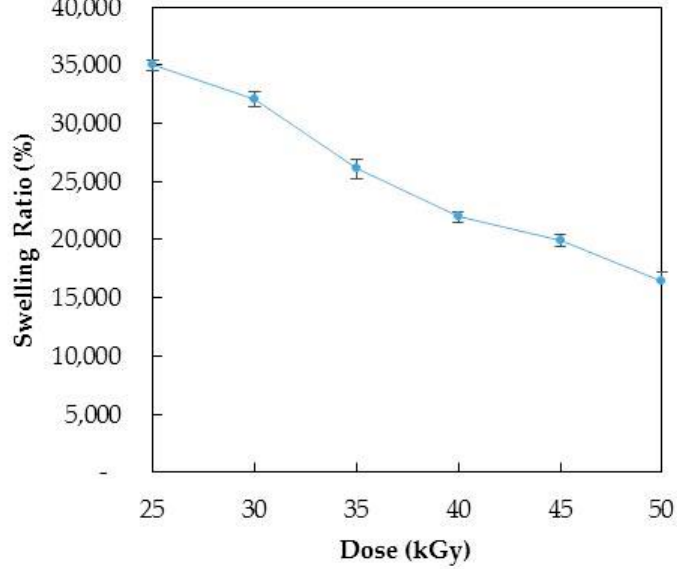
Figure 2. Effect of radiation dose on swelling ratio of PA15 hydrogel.